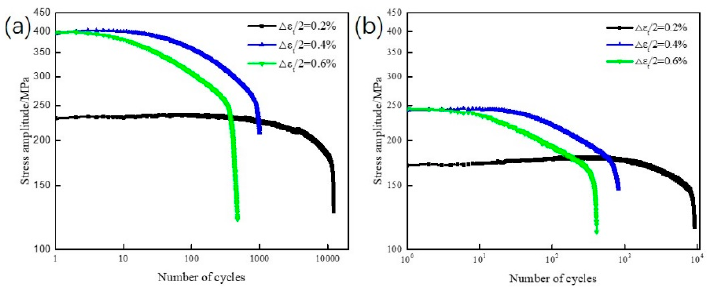
Figure 5. Cyclic stress response of the test steel at 700 °C: ( a ) novel steel and ( b )